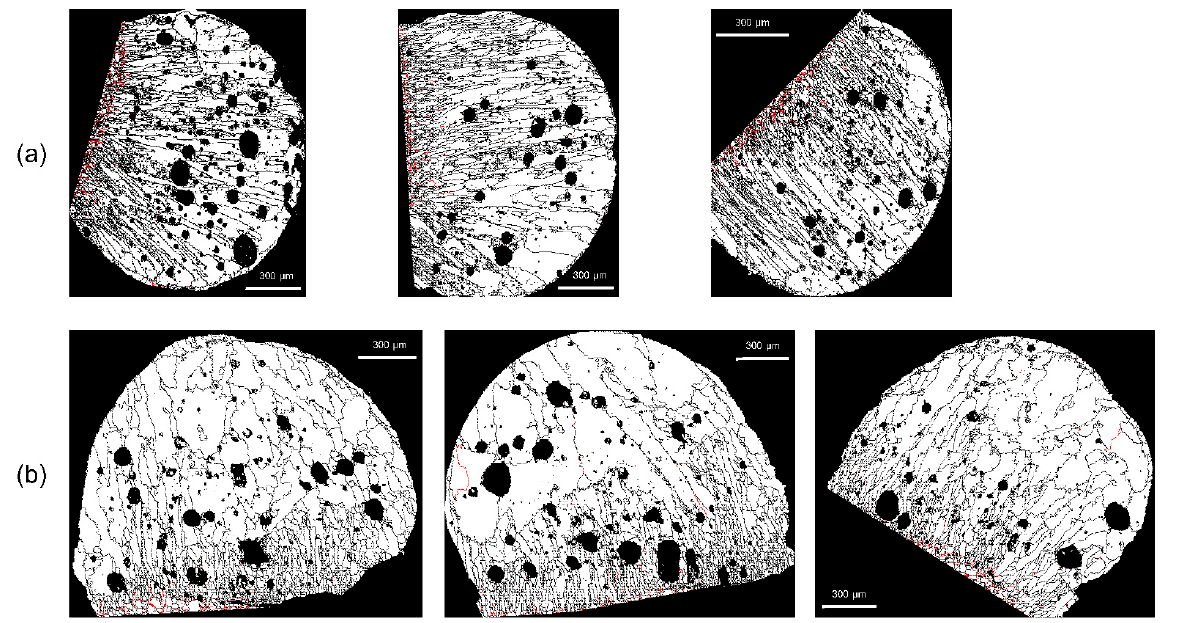
Figure 6. Distribution of Σ 3 boundaries (red line) in the molten marks: ( a ) PAB-25 and ( b ) PAB-600.